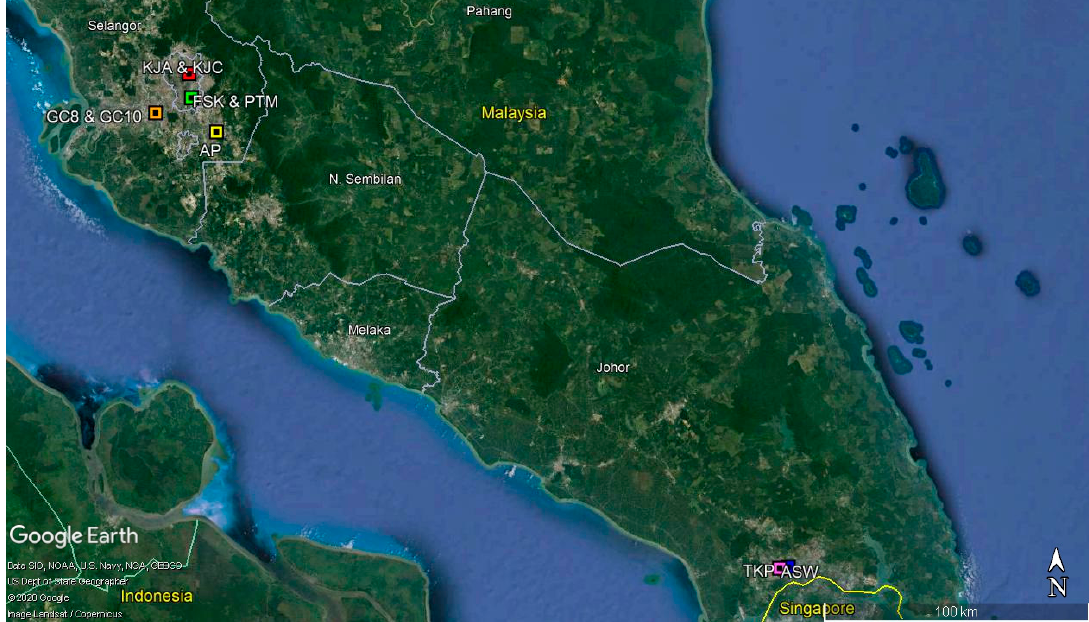
Figure 1. The geographical map of the study sites. Abbreviations: GC8—Goodyear Court 8, GC10—